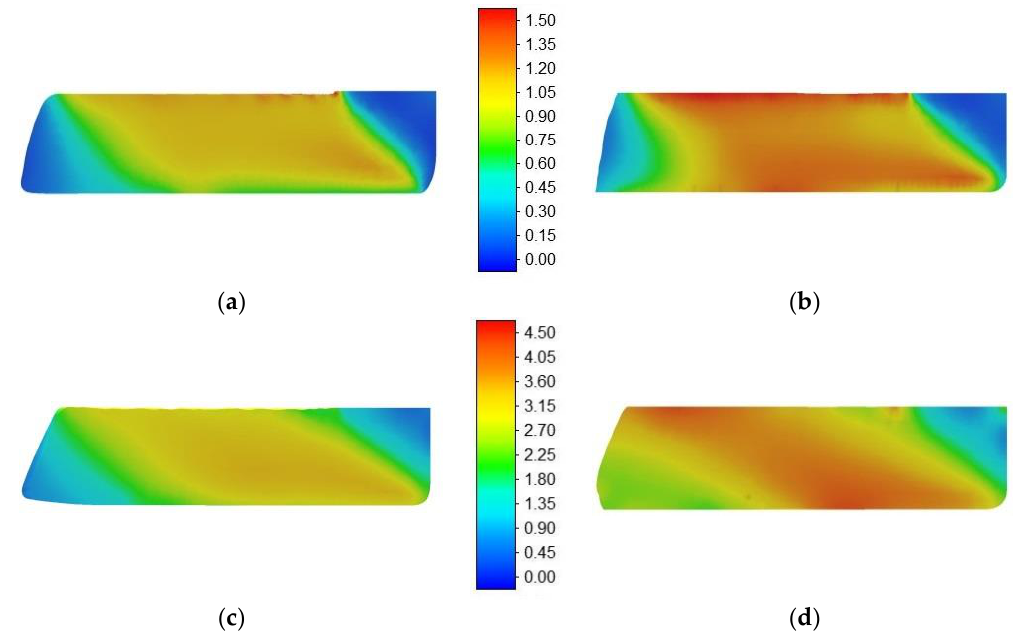
Figure 2. The effective plastic strain distribution after ECAP and TCAP processing in longitudinal direction: ( a ) after the first ECAP pass; ( b ) after the first TCAP pass; ( c ) after the third ECAP pass; and ( d ) after the third TCAP pass.